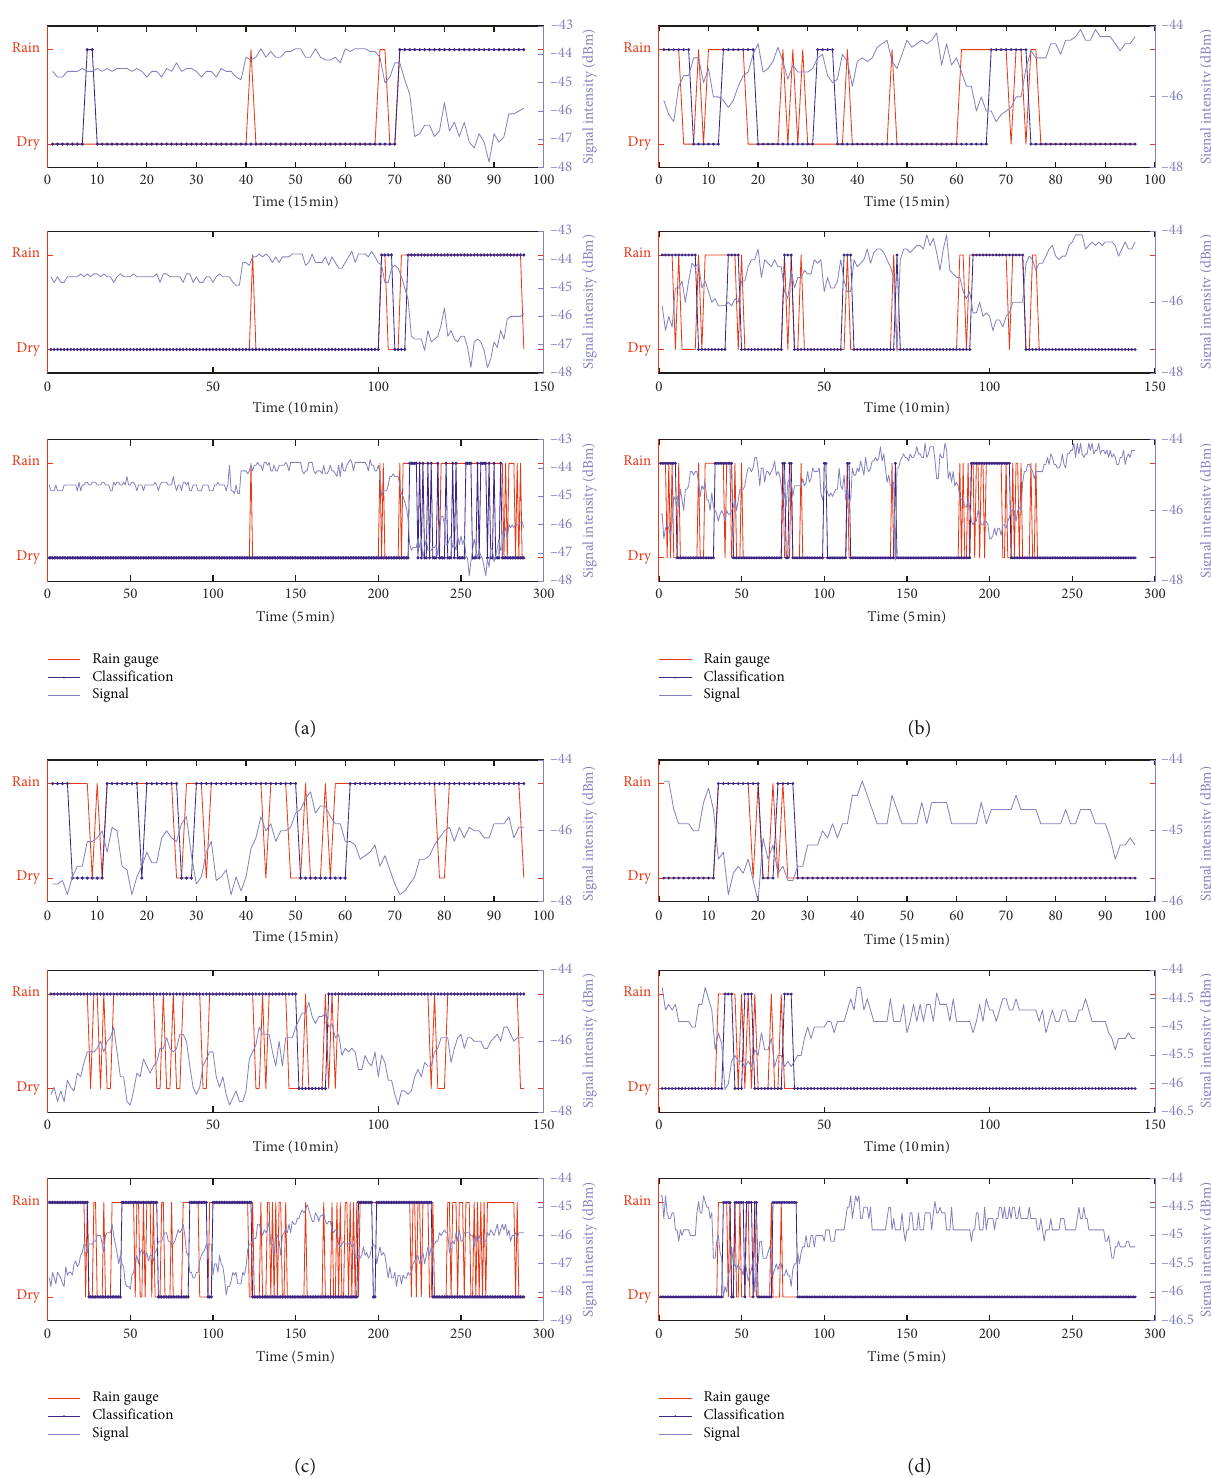
Figure 8: Results of the wet and dry periods. (a) 5th December. (b) 6th December. (c) 7th November. (d) 11th Figures 8(a) and 8(b) show the classification results of classification results (Classification), and the light-colored the wet and dry periods on 5th and 6th December using the line denotes the original RSL of the input classifier (RSL). classifier constructed with the November data. The red line For the 15 min time window, the classification of long-term denotes R w (Rain gauge), the blue dotted line denotes the and continuous precipitation is not ideal. The precipitation